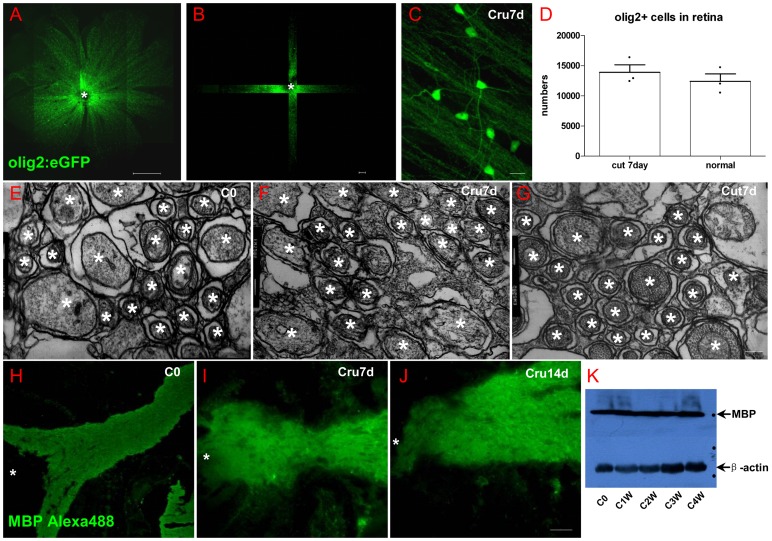
Oligodendrocytes in retina did not decrease after optic nerve injury.(A) Scan the whole retina with 10× objective of LSM710. (B) Cruciated scan in 3D way for counting the destiny of olig2+ cells. (C) The processes of oligodendrocytes keep integrality after ONI. (D) Oligodendrocytes number did not decrease at one week after ONT. (E-G) TEM images also show that myelin structure within NFL keeps integrity in ONC or ONT model within the first week. (H-J) Both IHC and western blot results (K) indicated that MBP in retina was not decreased after optic nerve injury, * indicates lens; Scale bar: 200 µm (A); 50 µm (B, H-J), 10 µm (C); 200 nm (E-G).